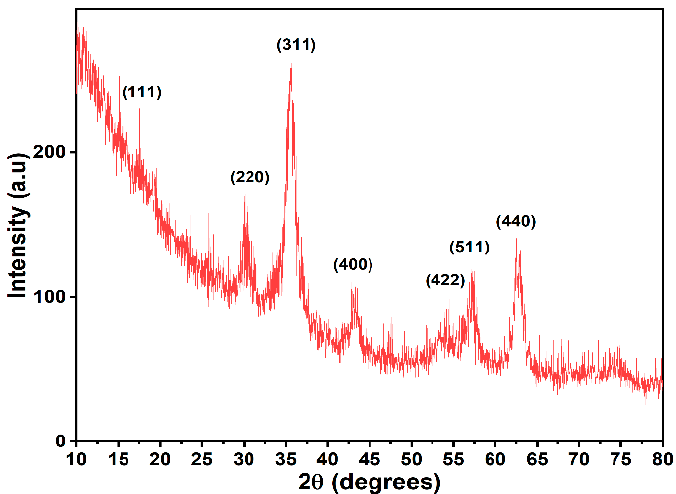
Figure 2. X-ray diffraction pattern of as-synthesized Fe 3 O 4 .